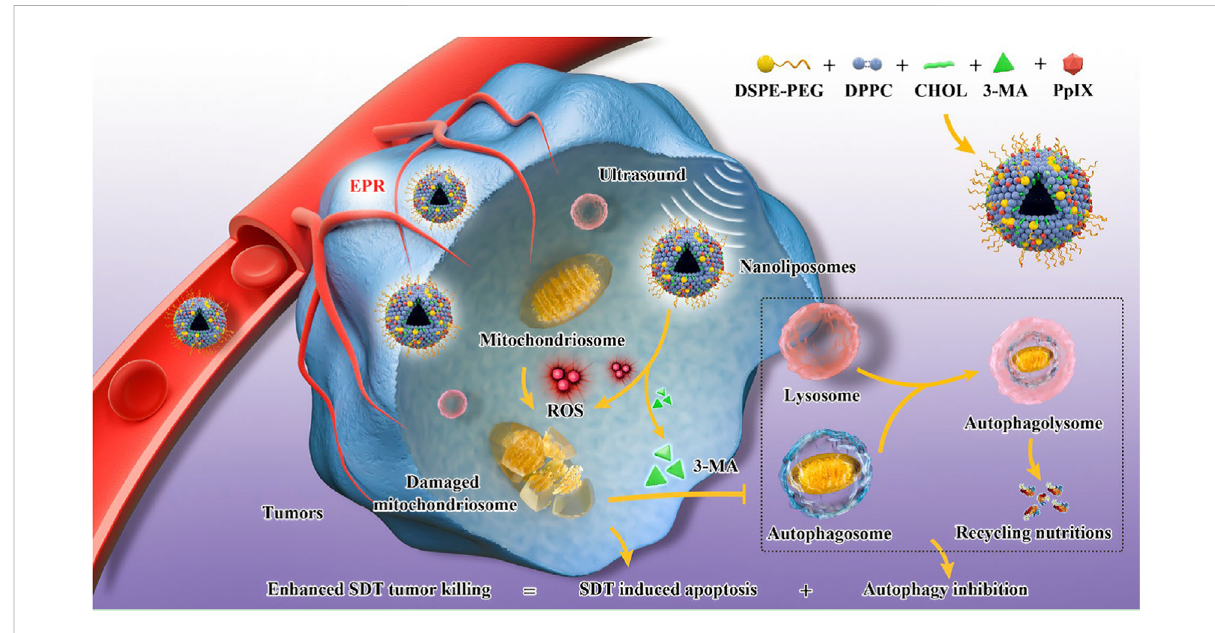
FIGURE 6 Engineering PpIX/3-MA@Lip nanosonosentizer for synergistic SDT nanotherapeutics and autophagy blockage on combating cancer. The synthetic procedure of PpIX/3-MA@Lip nanosonosensitizers and schematic illustration of “ all-in-one ” strategy for cellular mechanism on SDT- inducedcytoprotectiveautophagyandautophagyinhibition-enhancedantitumoref fi cacyofSDT.EnhancedproductionofintracellularROSradicals by PpIX sonosensitizers-based SDT induced cytoprotective pro-survival autophagy. The integrated 3-MA inhibited the formation of autophagosomes in early-phase autophagy to eliminate the recycling nutrients for ful fi lling the needs of cancer-cell adaptation and growth, which signi fi cantly induced the cancer-cell apoptosis and death. Copyright 2021, Journal of